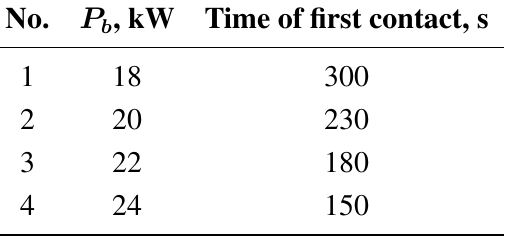
Table 3. First moment of contact between the molten pool and G2 boundary.